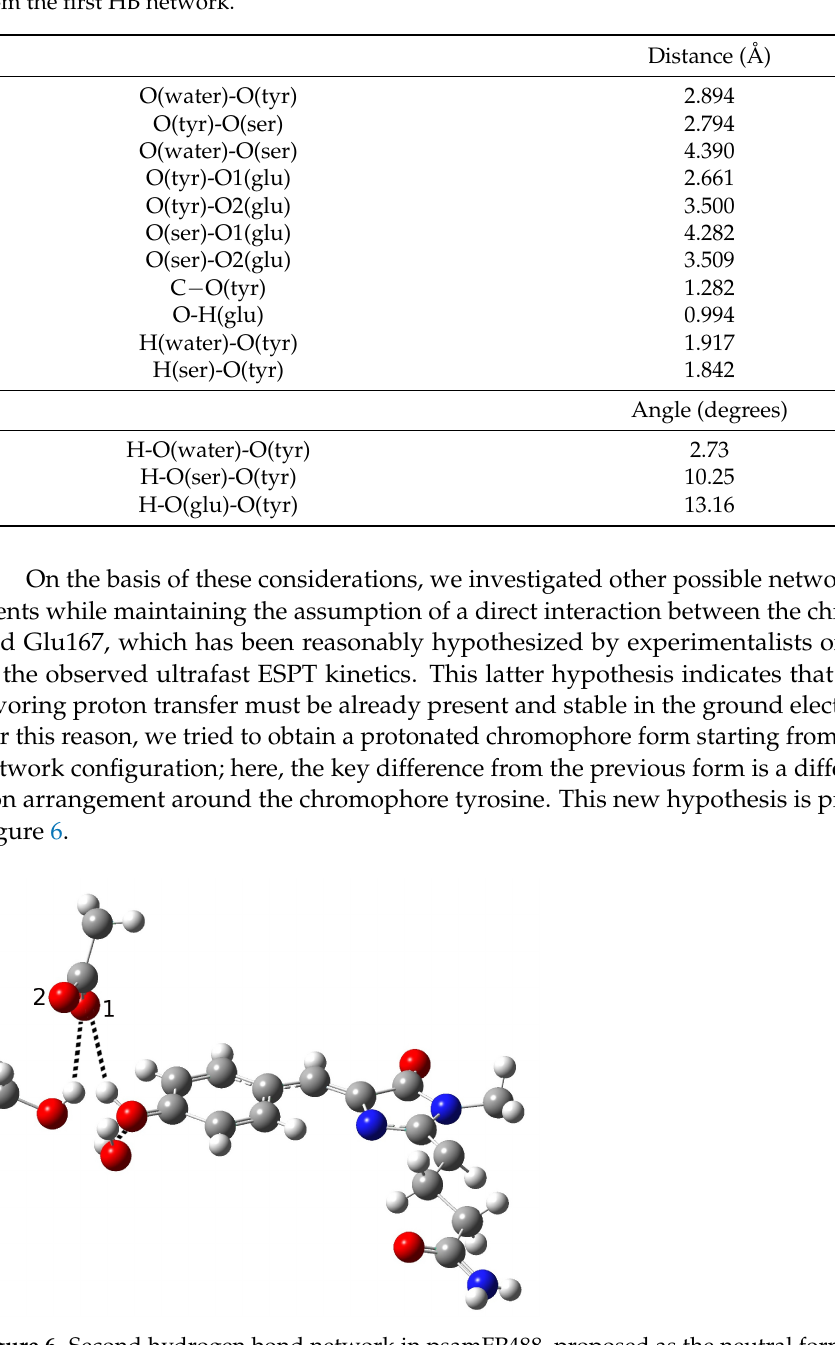
Figure 6. Second hydrogen bond network in psamFP488, proposed as the neutral form leading to ESPT on the basis of the experimental